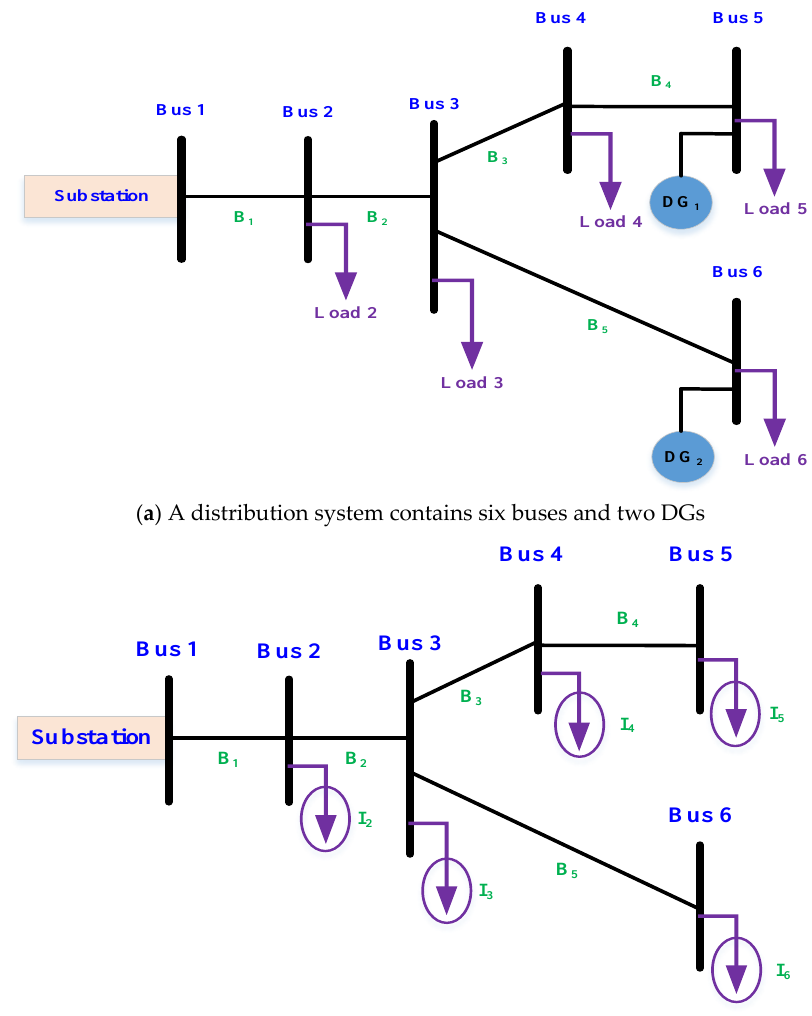
Figure 3. A typical single-line diagram of DN with the integration of distributed generators.